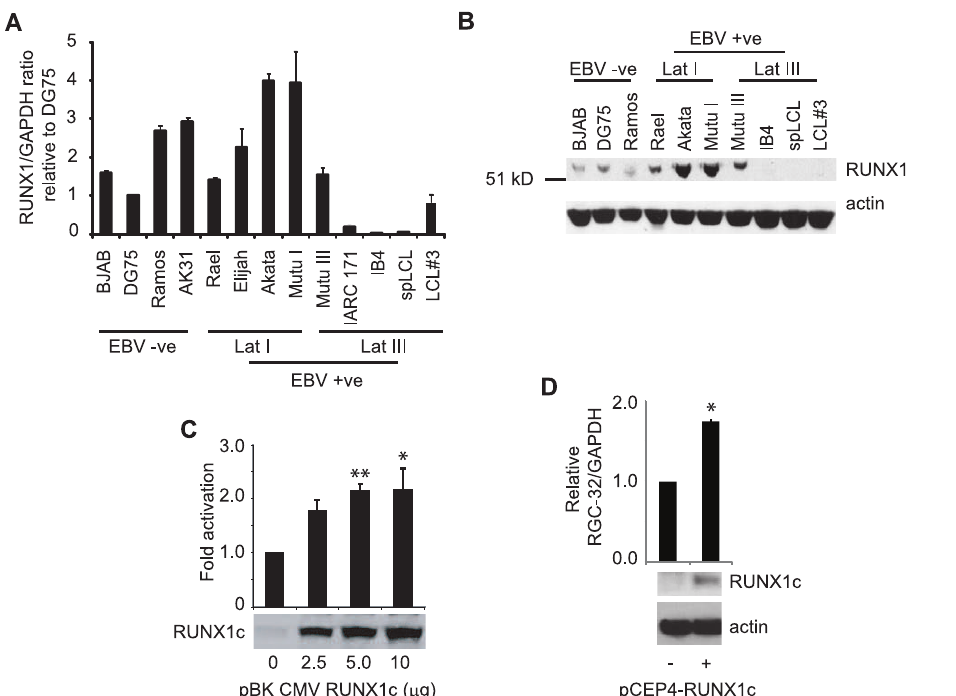
Figure 4. RGC-32 is transcriptionally regulated by RUNX1c in B-cells. (A) Q-PCR analysis of RUNX1c mRNA levels. Transcript quantities were normalized to those of GAPDH and then expressed relative to the signal obtained in DG75 cells. Results show the mean of 3 independent experiments + / 2 standard deviation. (B) Western blot analysis of RUNX1c protein expression in a panel of EBV negative and positive B-cell-lines. Actin levels serve as a loading control. (C) Transient reporter assays in DG75 cells transfected with 4 m g of the RGC-32 promoter-reporter construct (pRGC- 32pluc), 2 m g pRL-CMV as a transfection control and increasing amounts (2.5, 5 and 10 m g) of a RUNX1c-expressing plasmid (pBK-CMV-RUNX1c). Firefly luciferase signals were normalized to Renilla luciferase signals. Results show the mean of 3 independent experiments + / 2 standard deviation. RGC-32 promoter activation is expressed relative to the RUNX1-negative control. ** P value , 0.01 (0.004), * p value , 0.05 (0.036). (D) IB4 cells were transfected with pCEP4 or pCEP4-RUNX1c plasmids and transfected cells selected in Hygromycin B. 6 days post-transfection samples were analysed for RUNX1c protein expression by western blotting using actin as a loading control and endogenous RGC-32 mRNA expression using Q-PCR. Results show the mean of 2 independent experiments 2 / + standard deviation. * P value , 0.05